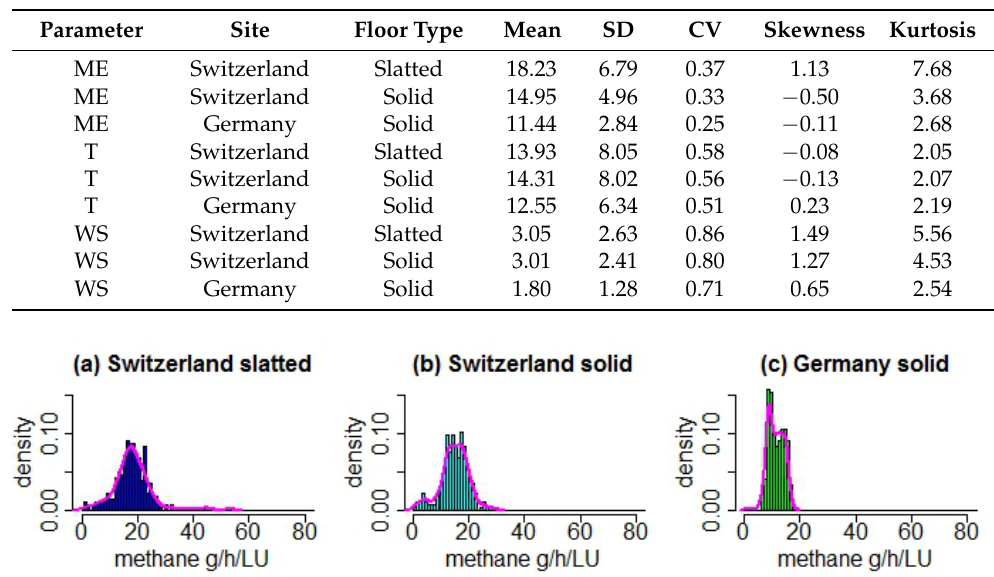
Table 2. Statistical moments associated with the probability density distributions of CH 4 emission (ME) in gh − 1 LU − 1 , ambient air temperature (T) in ◦ C and the magnitude of the approaching wind (WS) in ms − 1 for three naturally ventilated dairy housings. The same number of days per season was considered in all three cases. Due to some missing values, the total number of values in the hourly data sets varied between 265 (Swiss Slatted Floor), 264 (Swiss Solid Floor) and 275 (German Solid Floor). Here, SD refers to the standard deviation of the distribution and CV refers to the coefficient of variation, i.e., the ratio of standard deviation to the mean.